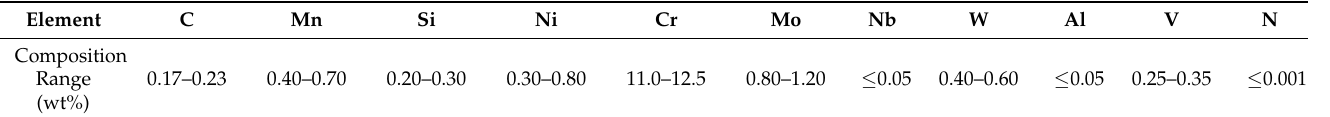
Table 1. Elemental compositions of the disc where LSM is performed.